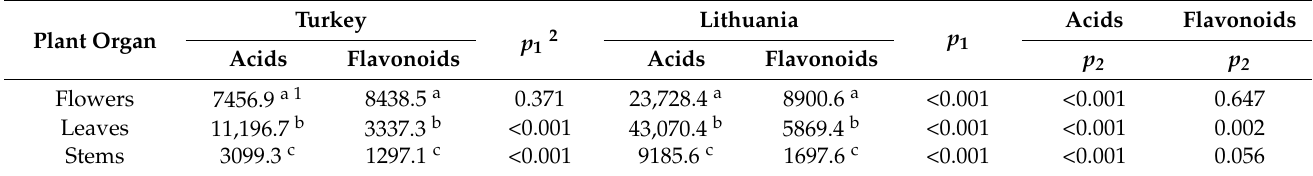
Table 3. Mean values ( µ g/g dry matter (DM)) of total phenolic acids and flavonoids in plant organs of Achillea millefolium from Turkish and Lithuanian populations. Significant differences ( p 1 ) between compound groups and differences ( p 2 ) between countries according to t -test.